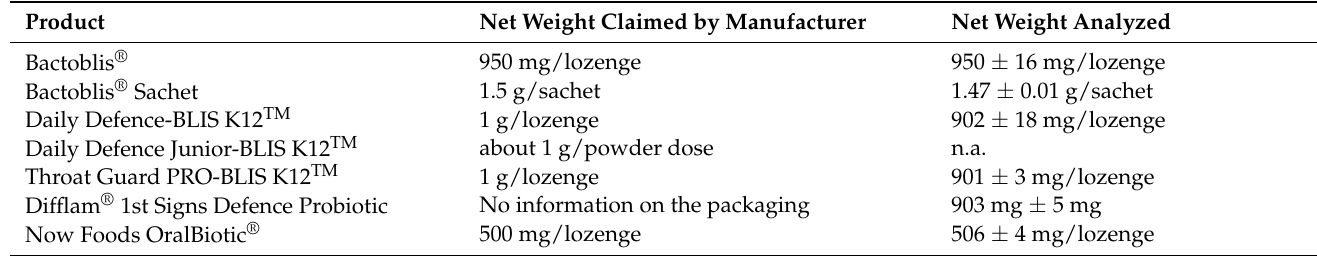
Table 2. Claimed and analyzed net weights of the commercial